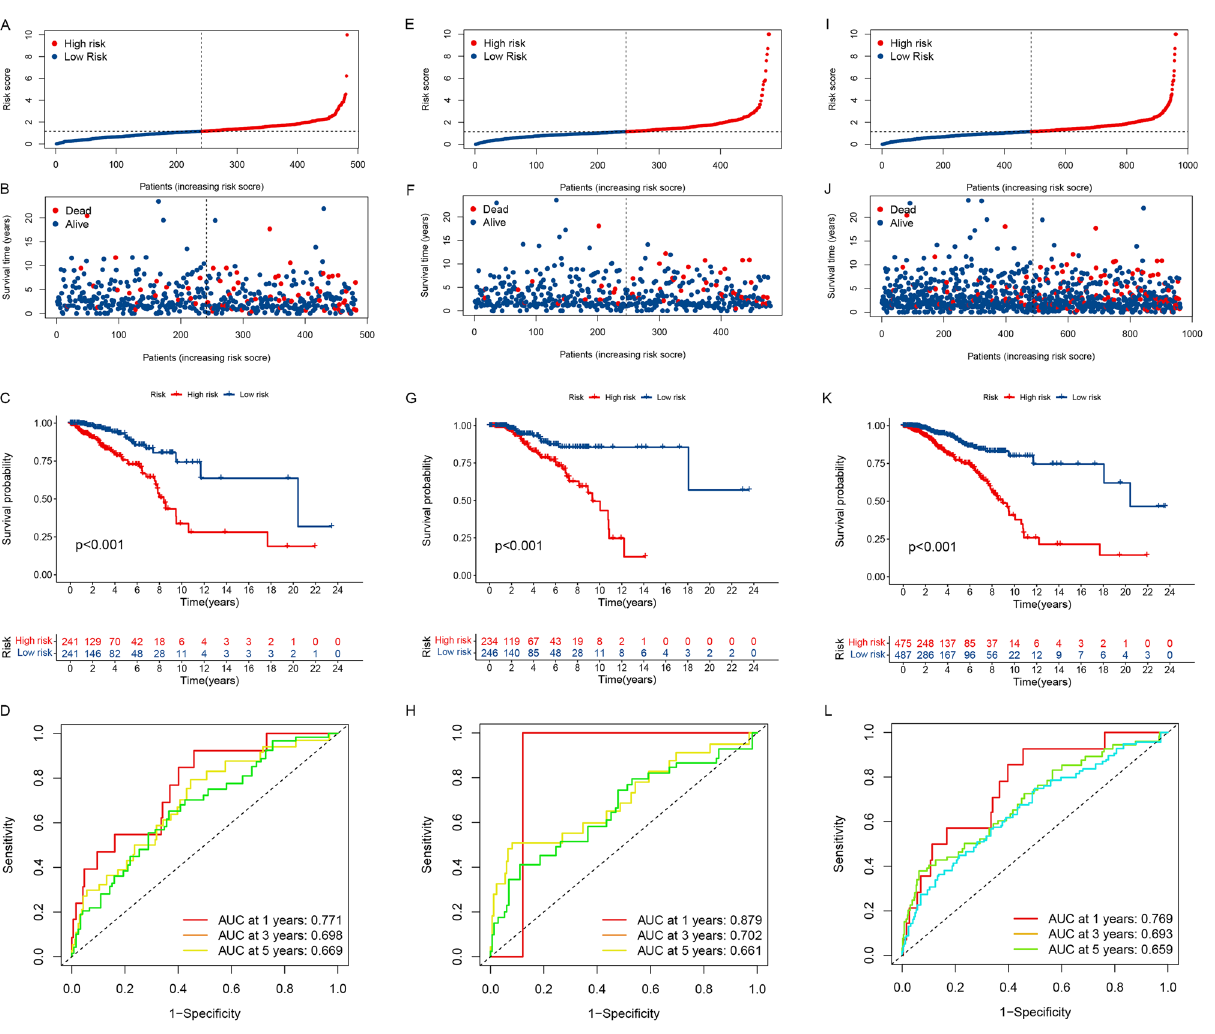
Figure 3. Prognostic analysis of the mitochondrial function-related lncRNA signature model. The distribution of the risk score in the training cohort ( A ), validation cohort ( E ), and entire cohort ( I ). The distributions of overall survival status in the training cohort ( B ), validation cohort ( F ), and entire cohort ( J ). Kaplan–Meier curves for the overall survival of patients in the higher- and lower-risk groups in the training cohort ( C ), validation cohort ( G ), and entire cohort ( K ). AUC of time-dependent ROC curves verified the prognostic accuracy of the risk score in the training cohort ( D ), validation cohort ( H ), and entire cohort ( L